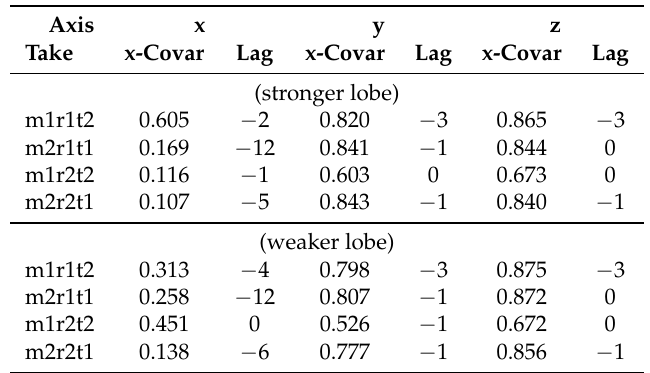
Table 6. RMSE and maximal ranges (per axis and method) in the comparison of displacement data of both systems—selected takes from musicians 1 and 2. Axis x y z RMSE ∆ Max RMSE ∆ Max RMSE ∆ Max take (cm) Mocap Imu (cm)